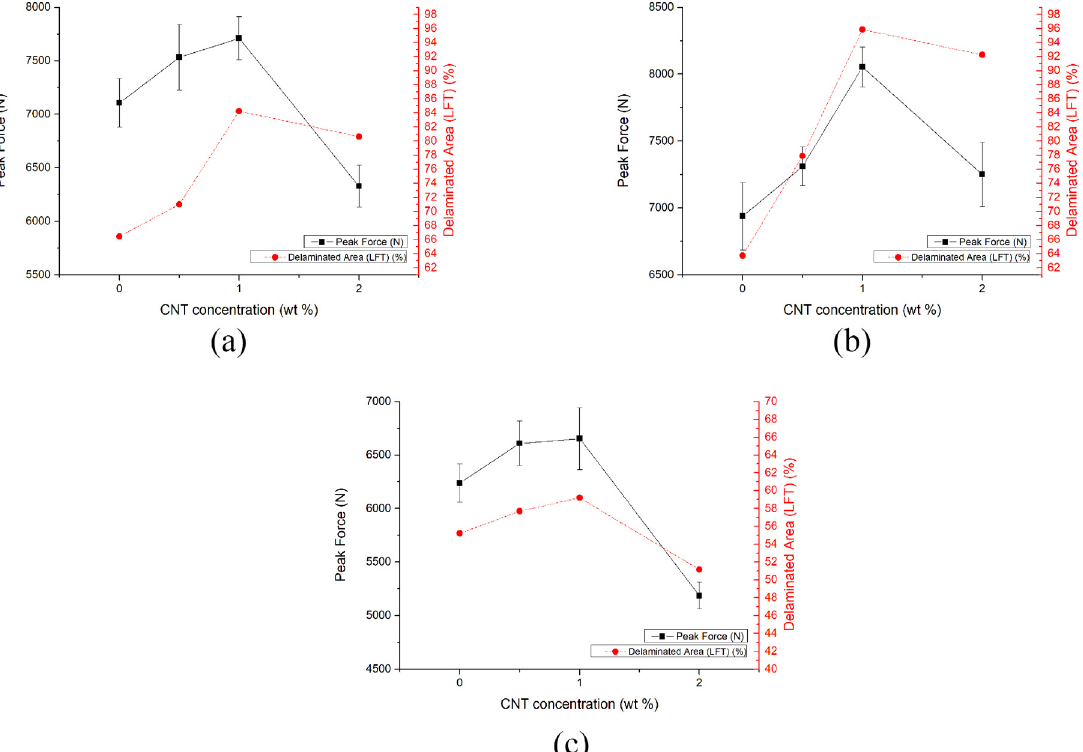
Figure 3. Peak force and LFT failure percentage: (a) Thickness: 0.05 mm; (b) Thickness: 0.15 mm; (c) Thickness: 0.40 mm